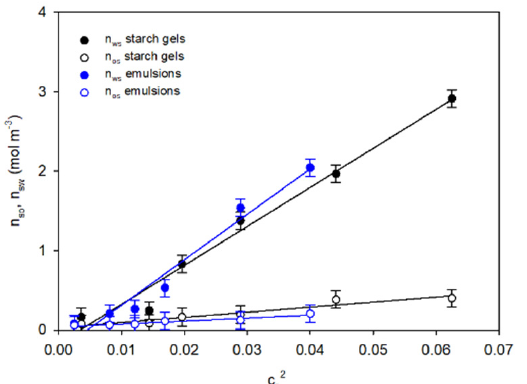
Figure 3. The concentration-dependent relationships of initial n o and final n w concentrations of spatial network segments of the starch gels and starch–fat emulsions. The values are expressed as means ± SD ( n = 3).